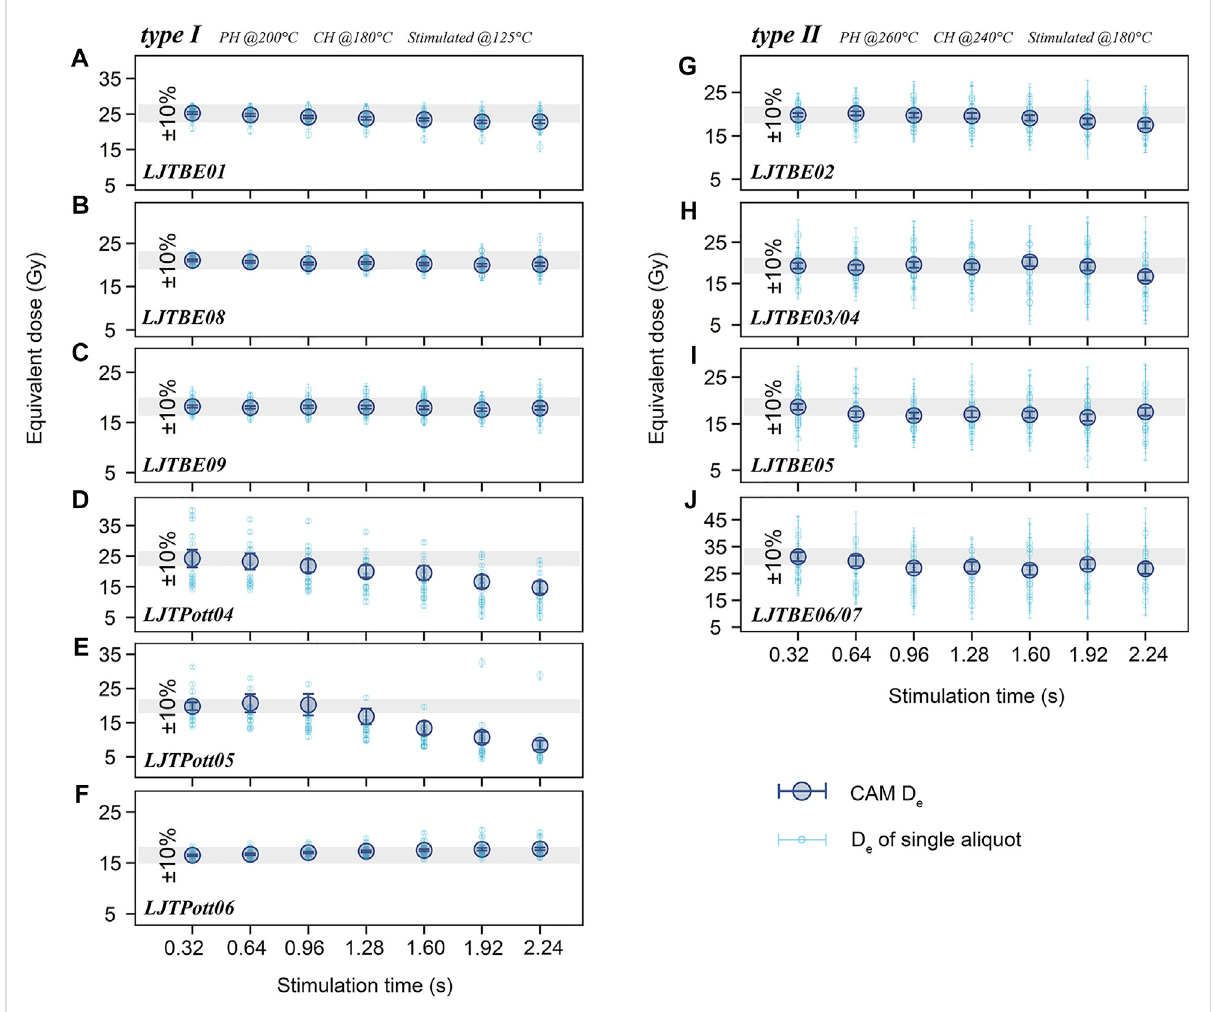
FIGURE 10 (A – F) D e (t)plotoftypeIsamples.ThesmalllightbluehollowcirclerepresentstheD e valuesanditsstandarderrorforonealiquot.Thelargedark blue fi lled circle represents the CAM D e and its error. The integration intervals of stimulation times were 0 – 0.32 s, 0.32 – 0.64 s, 0.64 – 0.96 s, 0.96 – 1.28 s, 1.28 – 1.60 s, 1.60 – 1.92 s, and 1.92 – 2.24 s, respectively. (G – J) Similar D e (t) plot of type II samples as in (A – F) . The gray bands represent the ±10% CAM D e error for the fi rst (0 – 0.32 s) integration